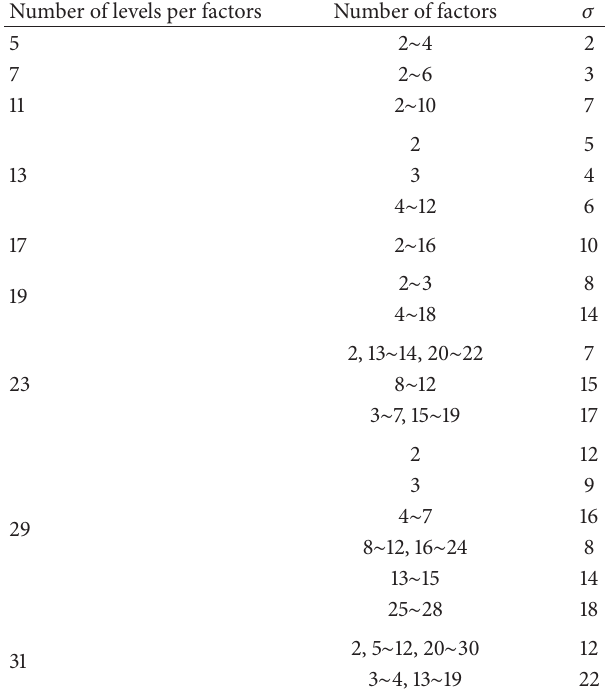
Table 1: Values of the parameter 𝜎 for different number of factors and different number of levels per